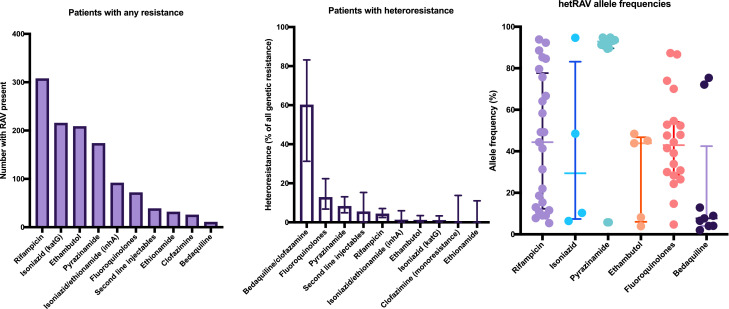
(a) Number of baseline isolates with genetic resistance (i.e. containing any RAV) by drug, (b) percentage of baseline isolates with hetRAVs only amongst all RAVs and (c) baseline allele frequency of all hetRAVs by drug, with lines showing median and interquartile range. Some isolates had >1 hetRAV.